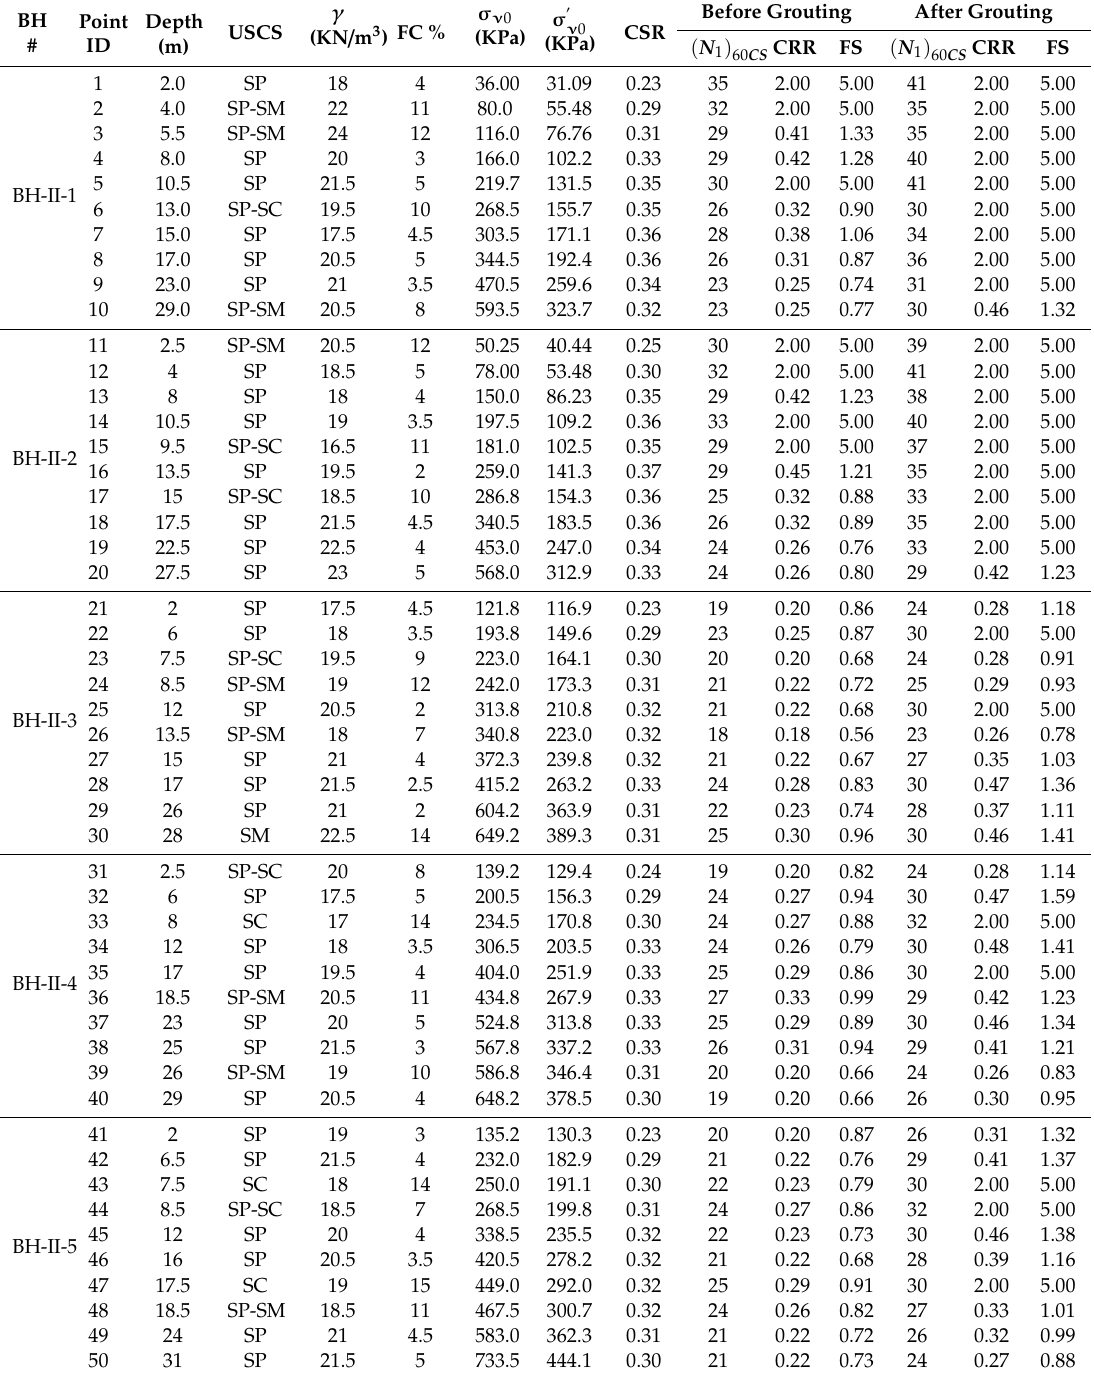
Table 2. SPT-based liquefaction triggering estimation prior to and after jet grouting using micropiles, following the Boulanger and Idriss